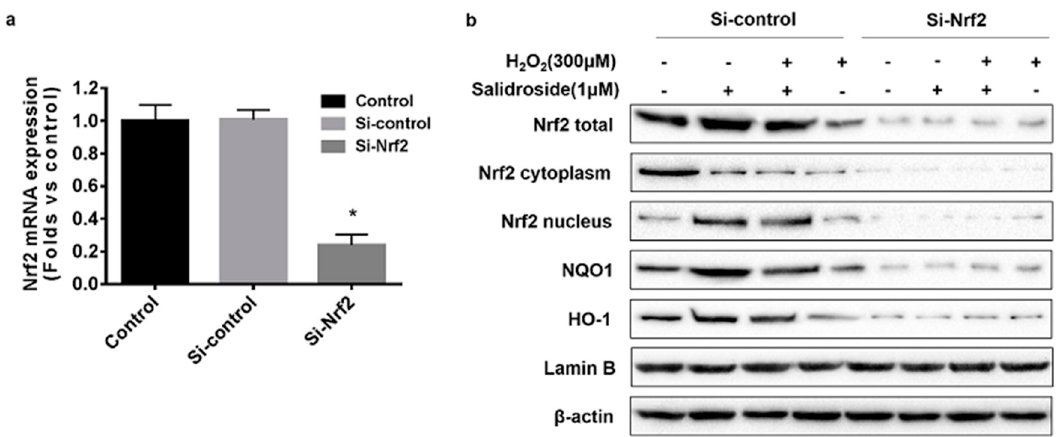
Figure 6. Effects of SAL on the expression of HO-1, and NQO1 in Nrf2 knockdown HUVECs. ( a ) HUVECs were transiently transfected with Nrf2 siRNA and scrambled siRNA, and incubated for 48 h. Nrf2 mRNA expression was determined using RT-PCR. The results of RT-PCR were normalized to β -actin, and expressed as fold change to control. The values represent the means ± SD of triplicate experiments. * p < 0.05 vs. control. ( b ) HUVECs were treated with Nrf2 siRNA and scrambled siRNA. After 48 h, the cells were incubated with 1 μ M SAL for 24 h, or 300 μ M H 2 O 2 for 4 h, or 1 μ M SAL for 24 h and 300 μ M H 2 O 2 for a further 4 h, and the protein levels of Nrf2 (total, nuclear, and cytoplasmic), HO-1, and NQO1 were determined using western blotting.